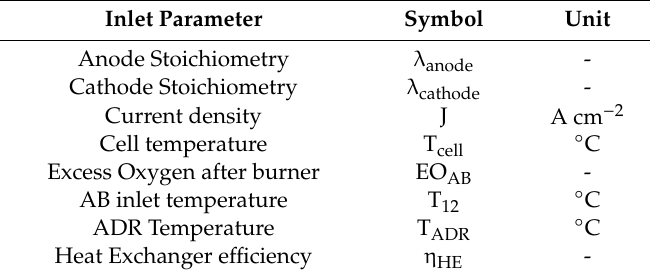
Table 1. Model input